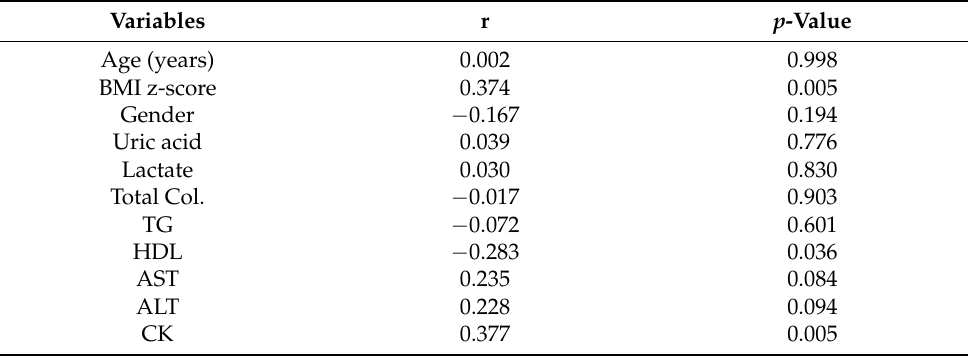
Table 3. Correlation analysis of risk factors for LV mass z score in child age.